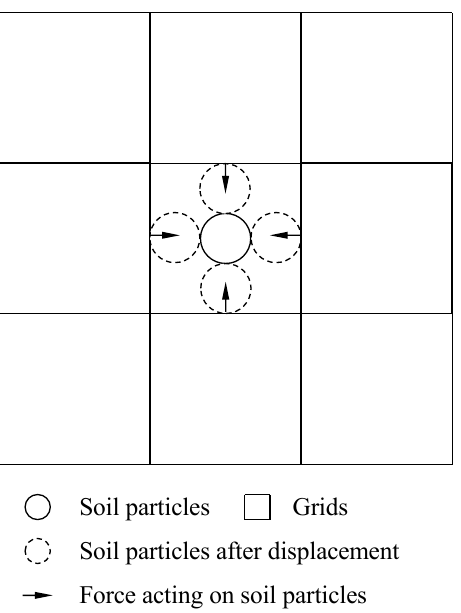
Figure 9. Schematic diagram of the grid interlocking